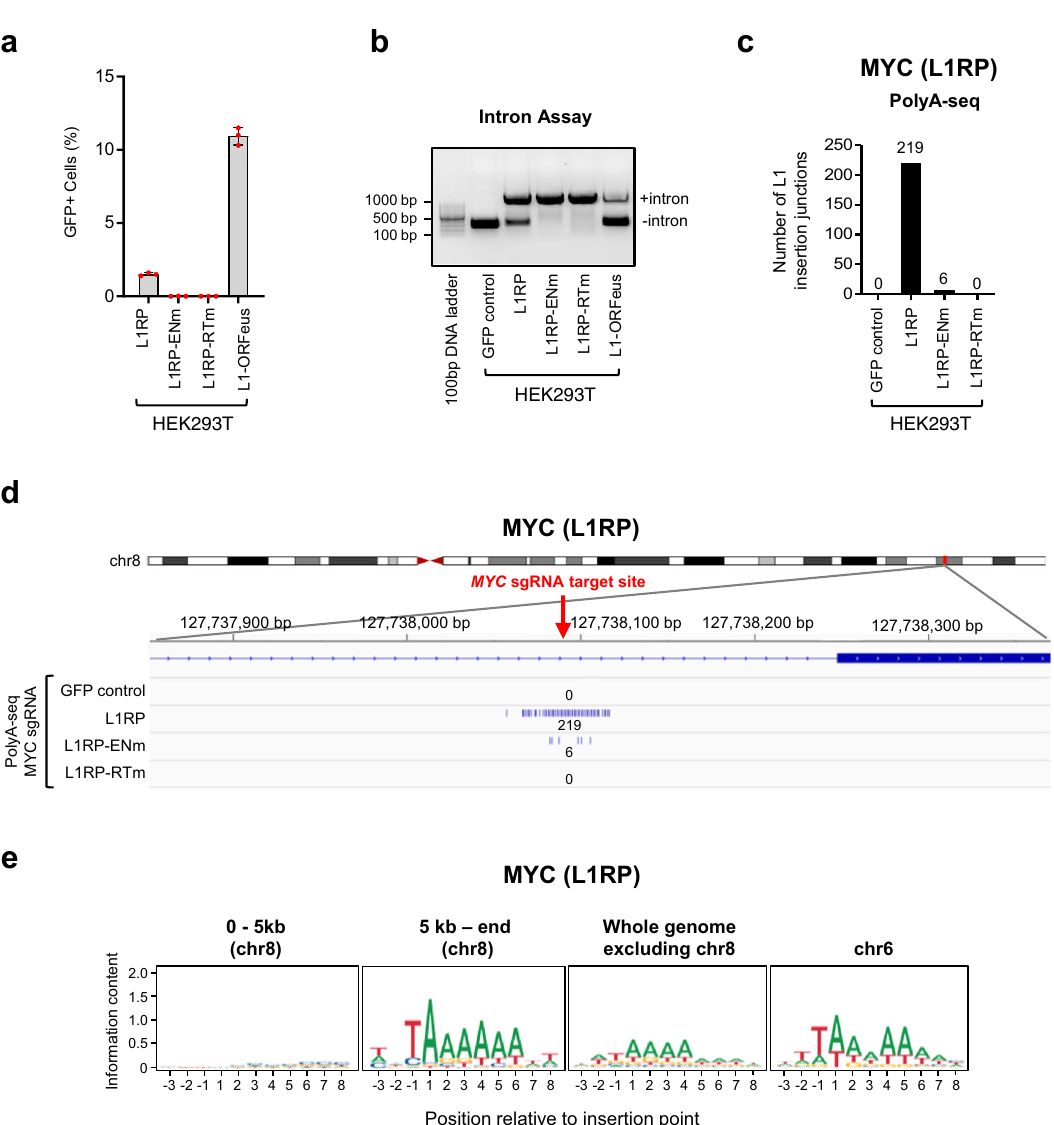
Fig. 6 RT-dependent de novo L1RP insertions at CRISPR/Cas9 target site in HEK293T cells. a The percentage of GFP-positive HEK293T cells was analyzed by FACS at day 11 after L1RP transfection and CRISPR/Cas9-mediated DSBs at the MYC locus as depicted in Supplementary Fig. 8b. Data are mean ± SD, n = 3 independent experiments. b PCR assay across the intron of the GFP reporter gene (Intron assay) was performed to probe the L1RP retrotransposition events by genomic DNA-PCR. HEK293T cells transfected with the same amount (1 μ g) of L1-ORFeus reporter served as a control. c Numbers of L1RP insertions obtained by PolyA-seq at the MYC locus targeted by MYC CRISPR/Cas9 in HEK293T cells expressing L1RP, L1RP-ENm, L1RP- RTm, or GFP control. d Detailed view of the distribution of L1RP insertions obtained by PolyA-seq at the MYC locus targeted by MYC CRISPR/Cas9 in HEK293T cells expressing L1RP, L1RP-ENm, L1RP-RTm, or GFP control. Each line corresponds to an independent L1RP insertion; number of L1RP insertions is pooled from four independent PolyA-seq experiments. Red arrow shows the MYC CRISPR/Cas9 target site. e Sequence logos representing the consensus motif detected at L1RP pre-integration sites in the indicated regions proximal or distant to the MYC CRISPR/Cas9 DSB in chromosome 8. The canonical consensus motif in chromosome 6 served as a control. Source data are provided as a Source data fi L1-ORFeus reporter (Supplementary Fig. 8c). The percentage of GFP + cells was lower with the L1RP reporter compared to L1- ORFeus reporter (Fig. 6a) and the PCR assay across the intron of the GFP reporter showed that the removal of the intron in the L1RP reporter was less ef fi cient than in the L1-ORFeus reporter, and not detected in the L1RP-ENm and L1RP-RTm mutants (Fig. 6b). Overall, these data are consistent with the lower retrotransposition ef fi ciency of a wild-type L1Hs retrotransposon reporter construct compared to the L1-ORFeus reporter.